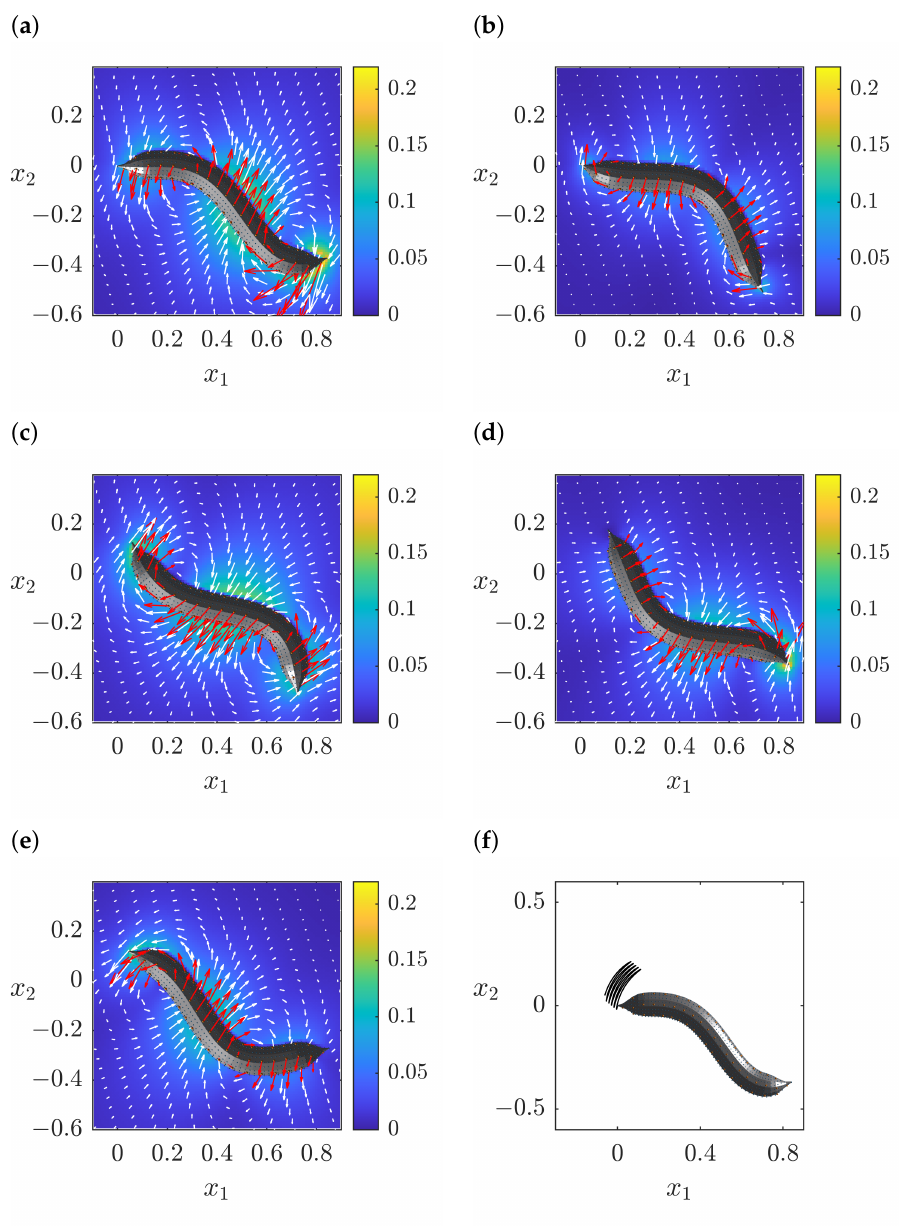
Figure 7. Undulating nonslender swimmer, full boundary integral calculation, with maximum radius a 0 = 0.06. ( a – e ) velocity field on the swimmer and in the fluid at five approximately equally spaced intervals during the beat cycle. ( f ) Trajectory of the leading point over four beat cycles (black solid line) and initial discretisation, with force points shown in red and quadrature points in